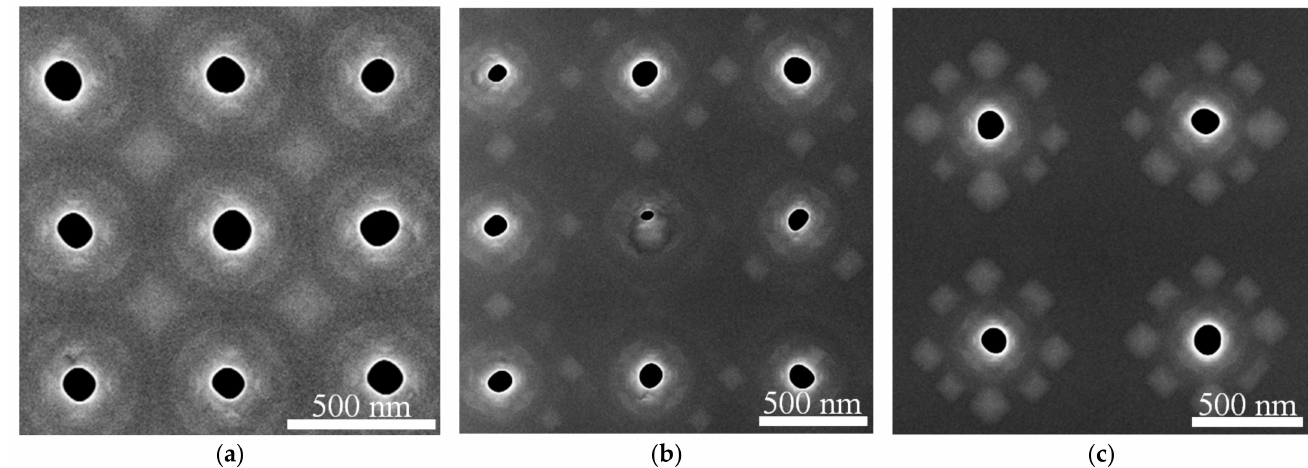
Figure 4. SEM images of ordered arrays of QDs produced by the deposition of ~4 ML of Ge on patterned SOI substrates with pit periods of 0.5 µ m ( a ), 0.7 µ m ( b ), 1 µ m ( c ). The dark areas correspond to pits; the bright areas correspond to Ge(Si) islands and elevations on the growth surface. The deposition temperature is 700 ◦ C. The rate of Ge deposition is 0.05 Å/s.